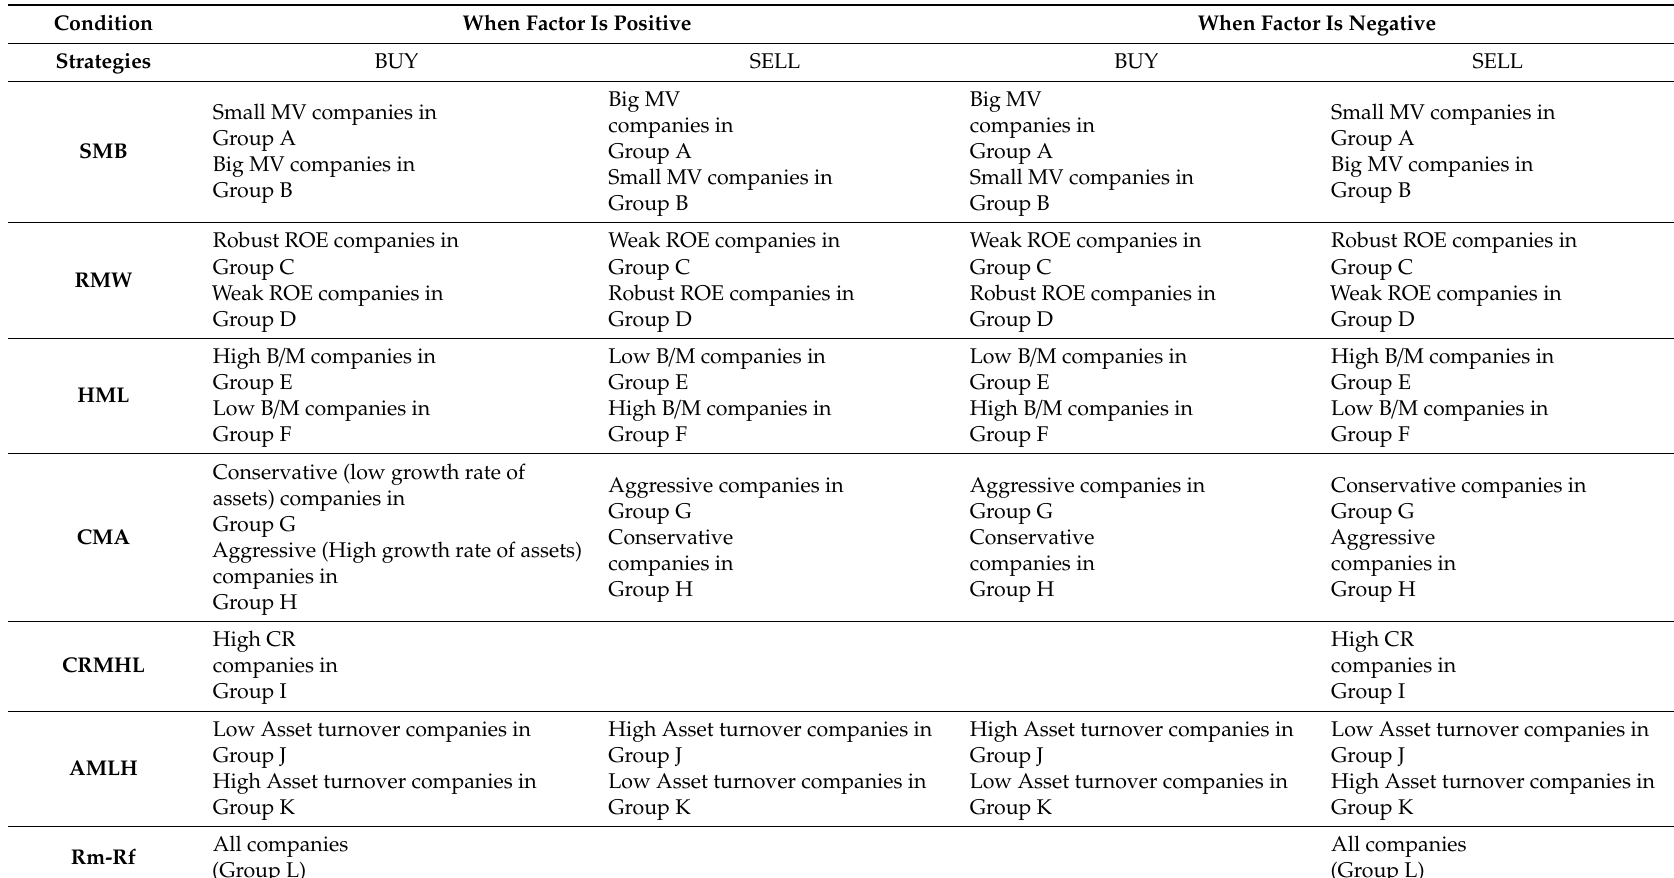
Table 6. Trading strategies based on condition of